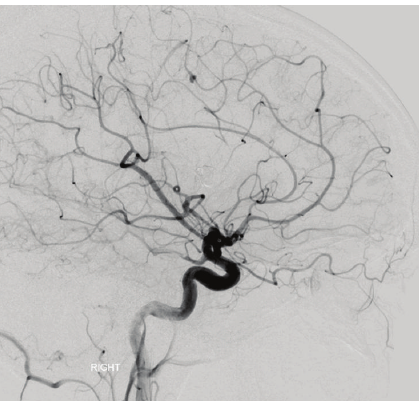
Figure9:Cerebralangiographic(DSA)imageinlateralviewofright ICA at 6-month follow-up, demonstrating complete obliteration of the embolized aneurysm with retrograde filling of the normal artery distal to the